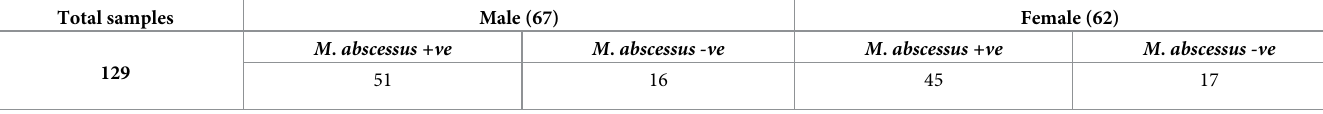
Table 2. Prevalence of gastric M . abscessus among male and female patients in Trivandrum. Total